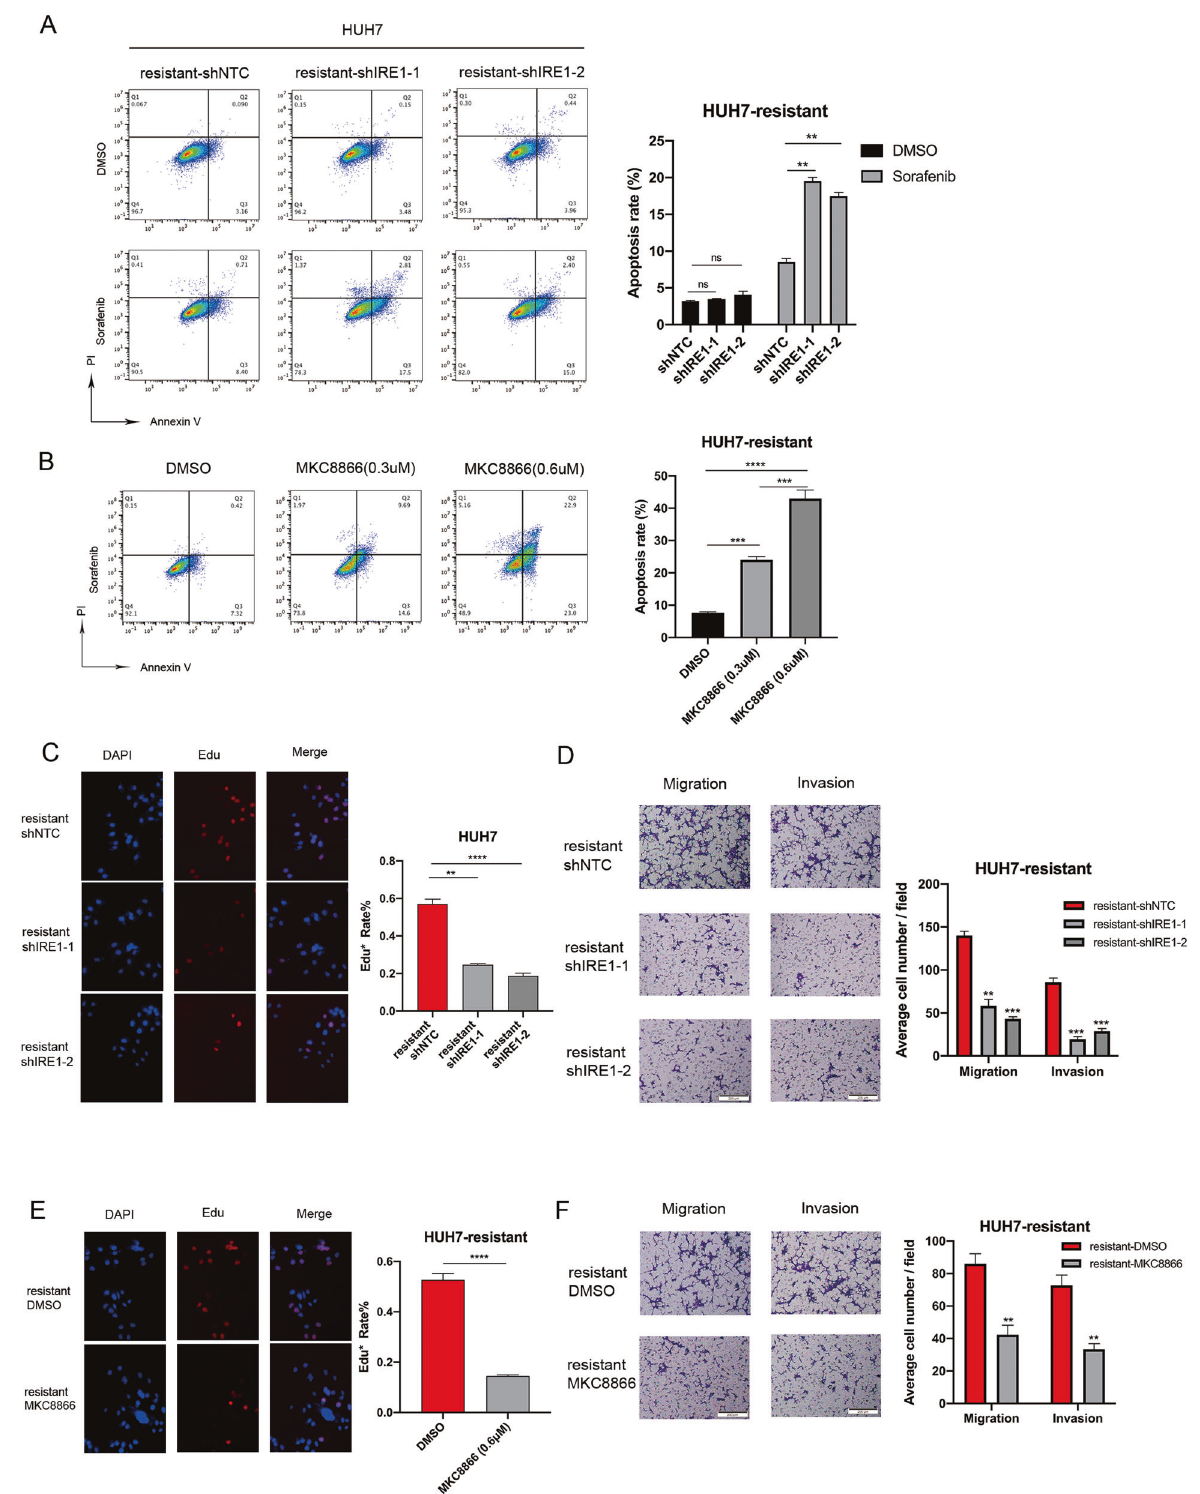
Fig. 4 The IRE1 α – XBP1s pathway is crucial for drug resistance and HCC malignancy. A Representative fl ow cytometry analysis of Annexin V-PI staining in sorafenib-resistant Huh7 cells with or without RCN1 silencing, in the presence of 5 μ M sorafenib. B Representative fl ow cytometry analysis of Annexin V-PI staining in sorafenib-resistant Huh7 cells in the presence of 5 μ M sorafenib and different doses of MKC8866. C Cell proliferation in sorafenib-resistant Huh7 cells with IRE1a knockdown assessed using an EdU assay. D Transwell assays of cell migration and invasion in sorafenib-resistant Huh7 cells after IRE1 α knockdown. E Cell proliferation in sorafenib-resistant Huh7 cells assessed using EdU assays after treatment with 0.3 μ M MKC8866. F Transwell assays of cell migration and invasion in sorafenib-resistant Huh7 cells in the presence of 0.3 μ M MKC8866. Data are presented as the means ± SEM of three independent experiments. ns not signi fi cantly different. ** P < 0.01; *** P < 0.001; **** P < 0.0001, t -test.